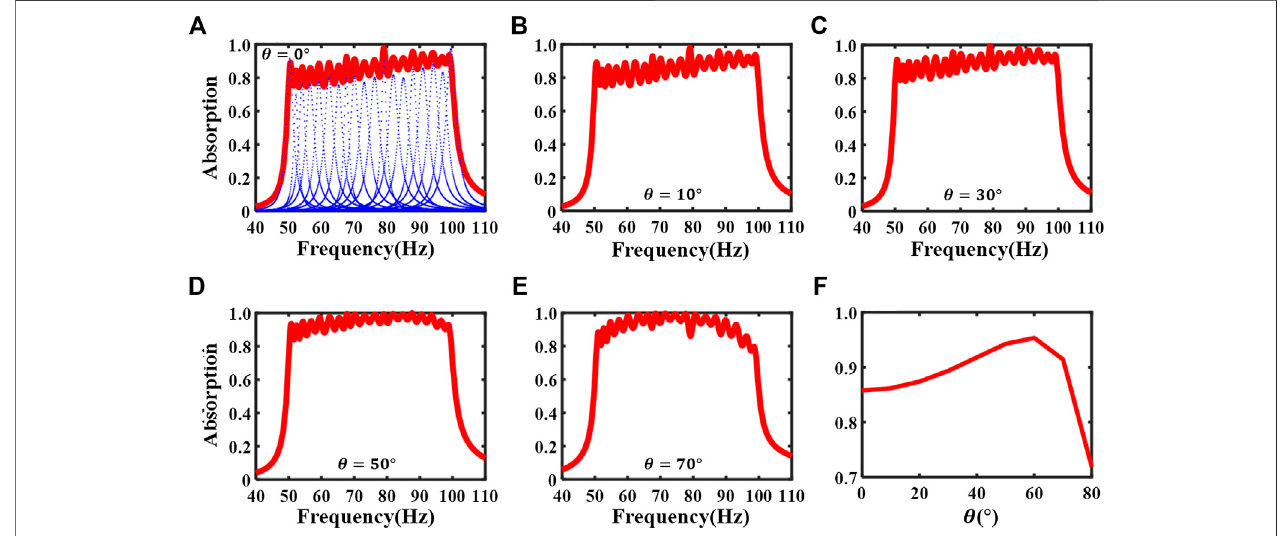
FIGURE 7 | (A) The absorption coef fi cient of the optimized supercell (red solid line) and individual unit cells (blue points lines) at normal incidence. (B – E) The theoretical absorption coef fi cients for the angles of incidence 10 ° , 30 ° ,50 ° , and 70 ° . (F) The theoretical average absorption coef fi cient over 50 – 100 Hz vs. angle of incidence.